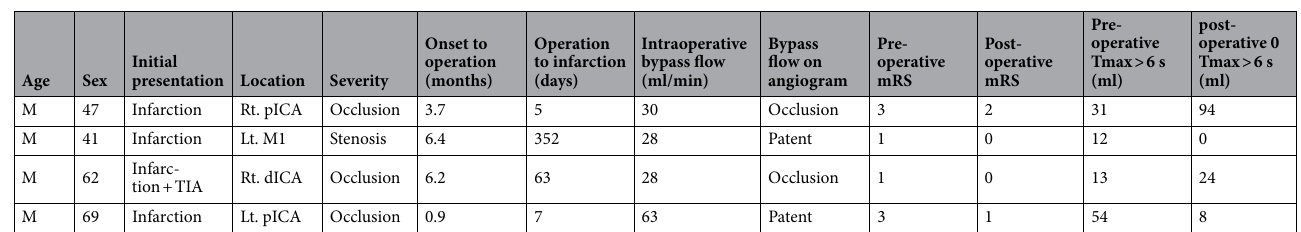
Figure 2. ( A ) The value of Tmax > 10 s continuously decreased as follows: preoperatively, 0 ml (0–5.25); immediately postoperatively, 0 ml (0–3); and 6 months postoperatively, 0 ml (0–0) ( p = 0.002). ( B ) The value of Tmax > 8 s continuously decreased as follows: preoperatively, 5 ml (0–43); immediately postoperatively, 0 ml (0–12.24); and 6 months postoperatively, 0 ml (0–4.25) ( p < 0.001). ( C ) The value of Tmax > 6 s continuously decreased as follows: preoperatively, 51 ml (8.25–145.25); immediately postoperatively, 20.25 ml (0–73.5); and 6 months postoperatively, 7.5 ml (0–42.25) ( p < 0.001). ( D ) The value of Tmax > 4 s continuously decreased as follows: preoperatively, 223 ml (116.5–321.75); immediately postoperatively, 143 ml (86.5–266); and 6 months postoperatively, 148.5 ml (52.25–323) ( p < 0.001).